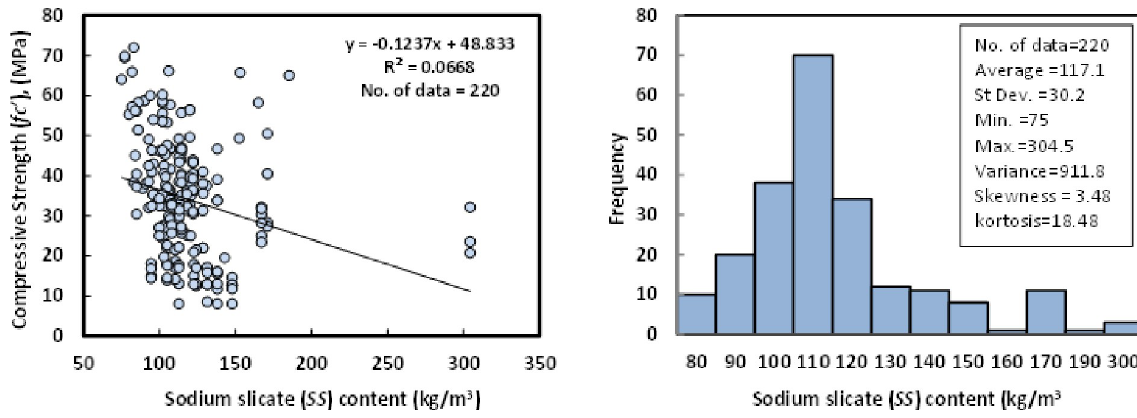
Fig 10. Relationship and a histogram of compression strength and sodium silicate content of GGBS/FA-GPC.